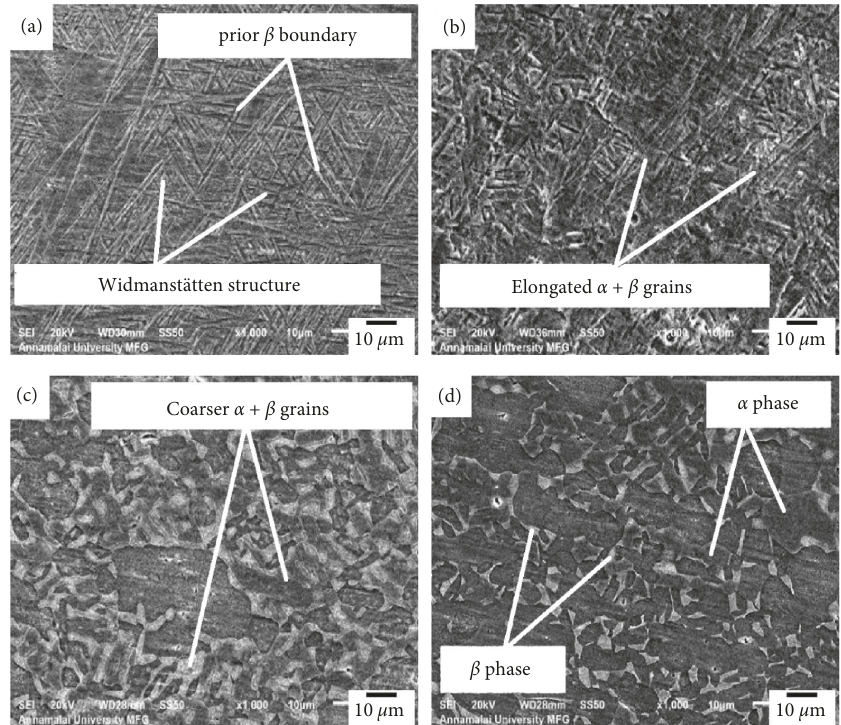
Figure 10: SEM micrograph of different regions of LFW-Ti6Al4V alloy joint: (a) weld interface; (b) TMAZ; (c) HAZ, and (d) unaffected parent metal.